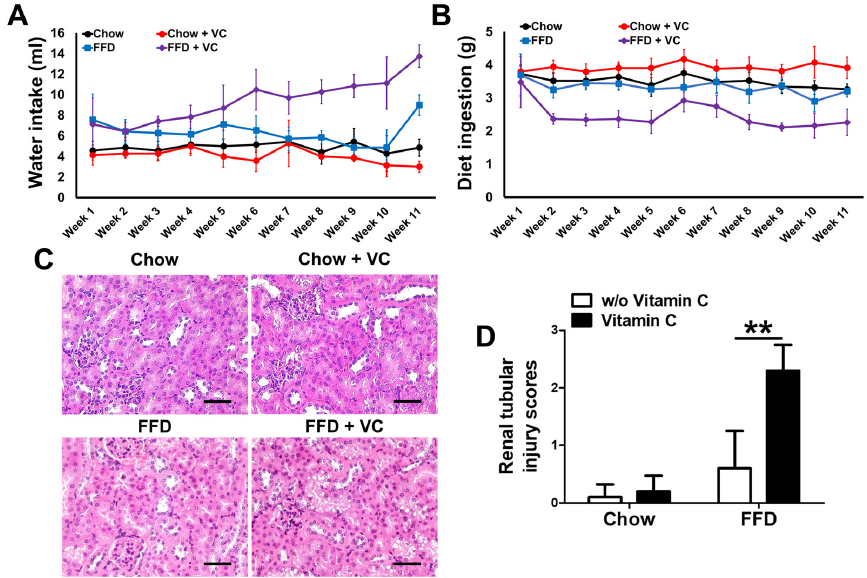
Figure 7. Comparison of diet ingestion, water intake and renal tubular injury. ( A , B ) For most of the experimental period, the FFD + VC mouse group exhibited higher water intake and lower diet food intake compared to other mice groups. ( C ) Representative H&E staining image of kidney. ( D ): His- topathological assessment of tubular damage. Data are expressed as means ± SD per group ( A , B , D ). n = 5 mice in each group ( A , B , D ). ** p < 0.01. Scale bars = 50 μ m ( C ). Original magnification, 400× ( C ). 4. Discussion In the present study, we evaluated the therapeutic effects of mega-dose vitamin C application in diet induced NAFLD and obesity animal models. For the entire experi- mental periods, the FFD + VC group exhibited significantly lower body weight compared to the FFD group. (Figure 1), and the hepatic fat contents including triglyceride and FFA were also significantly reduced by vitamin C supplements (Figure 2). The following his- topathologic examination revealed that the FFD + VC group had drastically attenuated NASH lesions compared to the FFD group. The total NASH-CRN grade scores were sig- nificantly decreased by vitamin C treatments in the FFD-fed mice groups (Figure 3). Se- rum biochemistry levels demonstrated that the hepatic enzymes ALT, ALP, and AST were elevated by 11-weeks of FFD feeding, while the serum levels of glucose and FFA were not affected by vitamin C treatments (Figure 4). These data indicated that the therapeutic ef- fects of mega-dose vitamin C are independent of nutrient absorption. In previous studies, prolonged high-carbohydrate and high-fat diets induce NASH development not only tri- glyceride accumulation in hepatocytes but also through infiltration of inflammatory cells into the liver parenchyma. [19] Consequently, Immunohistochemistry and qPCR results demonstrated that the mega-dose vitamin C treatment protects the liver from not only triglyceride accumulation but also infiltration of inflammatory cells and inflammatory cy- tokines (Figure 5). Immunoblot analysis demonstrated that the mega-dose vitamin C ap- plication did not increase the level of expression of proteins involved in catabolic activities in the FFD-fed mice (Figure 6). Therefore, we pose the question: how did the mega-dose vitamin C treatment significantly attenuate NAFLD progression independently of energy degradation? Interestingly, in this study, the FFD + VC group showed significantly higher water intake and lower food intake than FFD group (Figure 7A,B). Interestingly, the FFD + VC group was observed with notably increased urine volume (data not shown) com- pared to the FFD group. According to previous study, excessive intake of fructose-rich